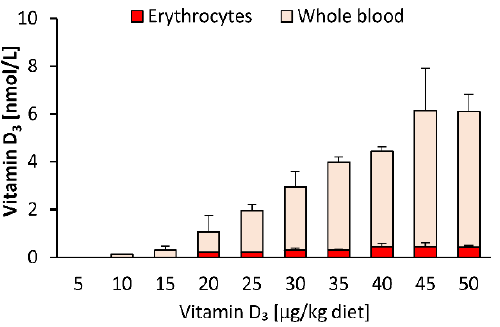
Figure 3. Concentrations of vitamin D 3 in erythrocytes and whole blood of mice that were fed 10 different doses of dietary vitamin D 3 for three weeks ( n = 3). Data are presented as the means ± SD.